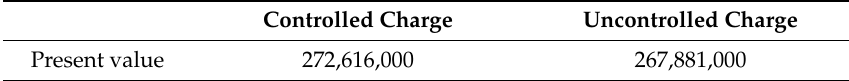
Table 6. Economic analysis results for the EB charging station.